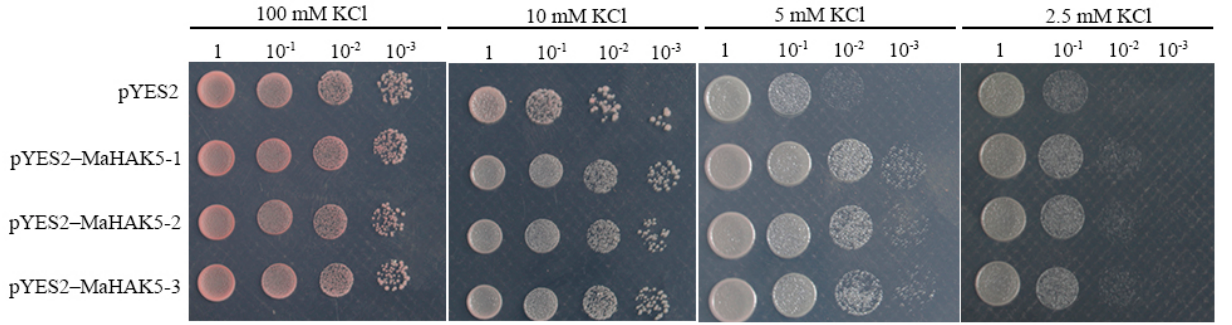
Figure 2. Subcellular localization of MaHAK5. Localization of MaHAK5 in tobacco leaves. GFP and GFP-MaHAK5 were transiently expressed in tobacco leaves.